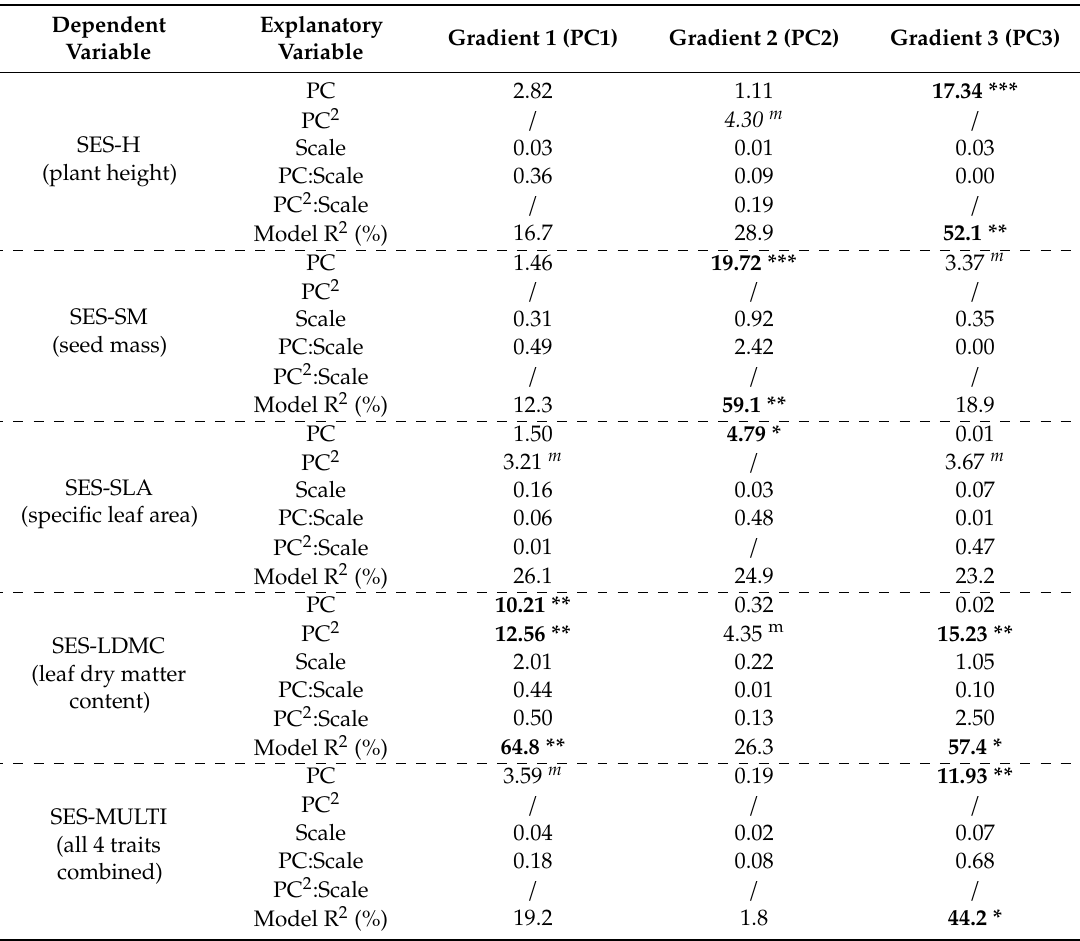
Table 4. Results of the ANOVA for standardized e ff ect size (SES) of functional dispersion for four functional traits and explanatory variables (PC1, PC2, PC3, spatial scale). F statistics and corresponding p -values are reported based on averaged site-level data ( n = 20). PC 2 denotes the quadratic term. The e ff ect of the interaction between ecological gradient (PC) and spatial scale was also